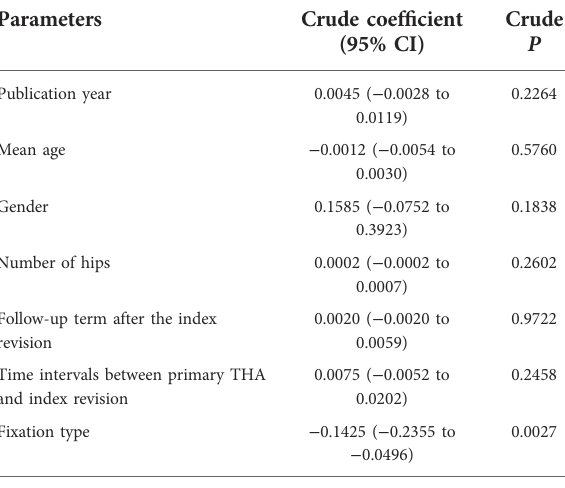
TABLE 4 Results of the meta-regression for re-revision rate for aseptic loosening.